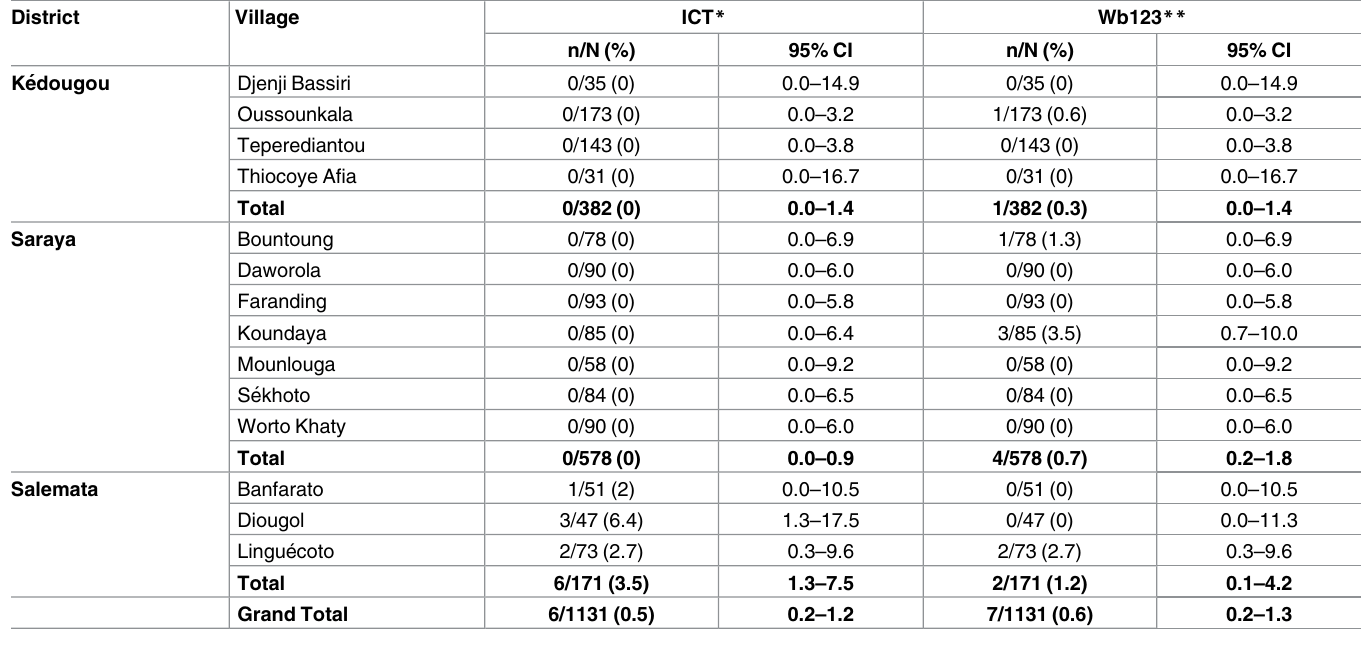
Table 2. Prevalence of lymphatic filariasis positive results by district and village, Ke´dougou Region, using two diagnostic tests District